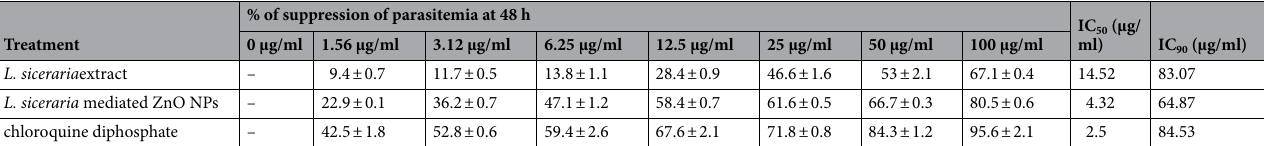
Table 3. In vitro anti-plasmodial activity of aqueous L. siceraria extract and its mediated ZnO NPs.